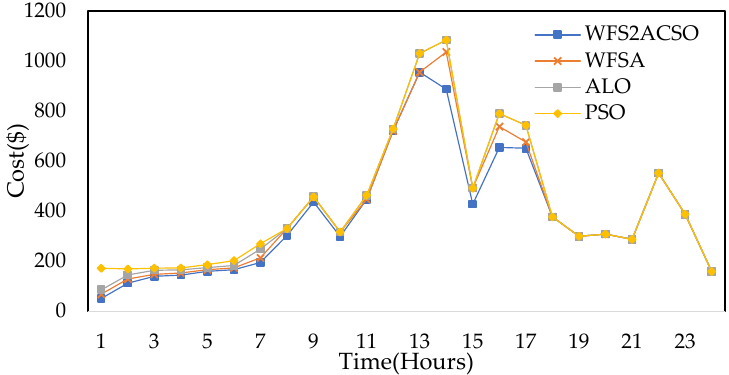
Figure 28. Cost comparison of various techniques for industrial area.